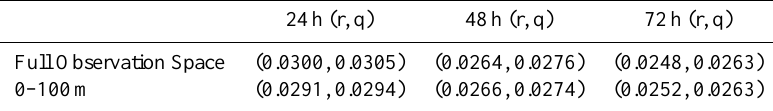
Table 3. Resolution for salinity.